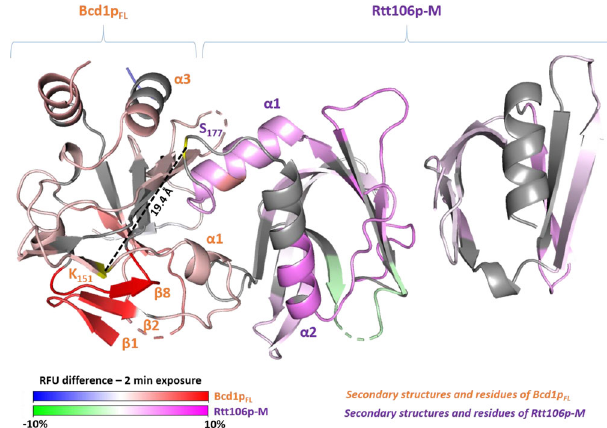
Fig. 7 Summary of the XL-MS and HDX-MS experiments. Relative fractional uptake (RFU) differences export on the crystal structure of the complex between Rtt106p-M and Bcd1p FL determined by hydrogen deuterium exchange mass spectrometry (HDX-MS) . Export is realized for 2 min deuteration experiments. Differences are color scaled on Bcd1p FL from blue (deprotection) to red (protection) upon Rtt106p-M binding ( − 10% to 10% RFU difference range). Differences are color scaled on Rtt106p-M from green (deprotection) to magenta (protection) upon Bcd1p FL binding ( − 10% to 10% RFU difference range). The C α -C α distances of intercross- linked peptides are represented with black dotted lines. Orange residues and secondary structures represent the most affected regions on Bcd1p FL while the purple ones represent the most affected regions on Rtt106p-M.